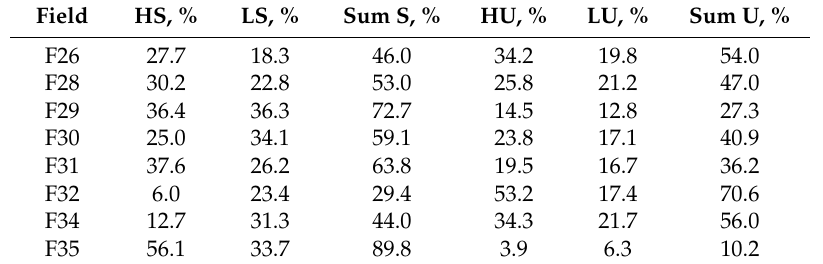
Figure 8. Spatial and temporal trend maps of cotton yield with 200 kg ha − 1 yield temporal stability threshold for eight fields in the Southern High Plains. Table 1. Spatial and temporal trend area in percentage with a yield stability threshold of 200 kg ha − 1 .